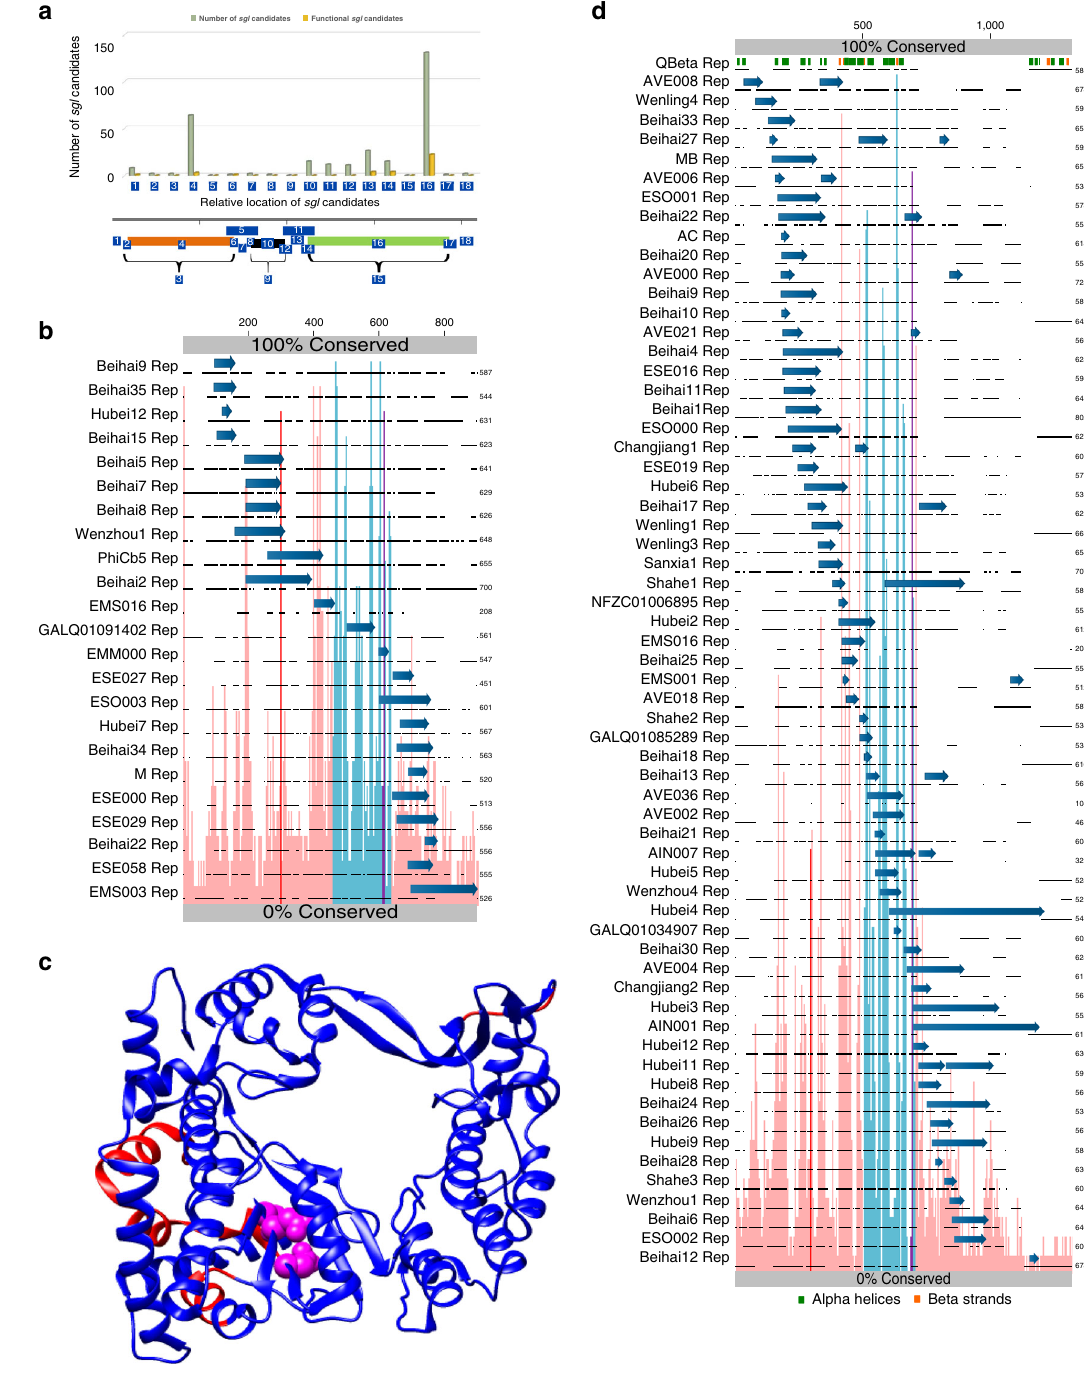
Fig. 2 Genomic hot spots for sgl evolution. a Relative location of sgl -candidates within a canonical ssRNA phage genome architecture. Numbers 1 through 18 refer to the sub-locations within the genome where sgl -candidates could potentially be found. The bars in the graph show the total number of sgl - candidates (light green) and functional sgl s (orange) per sub-location. b An alignment of Rep sequences from phage genomes that have rep -embedded functional sgl s. The regions of sequence similarity are shown as lines and the gaps are shown as breaks in the lines. The location of the sgl in the context of replicase primary structure is shown as a blue arrow above the line. Sequence conservation among the Rep sequences is shown as pink bars (0% at the bottom gray bar, 100% conservation top gray bar). The bars corresponding to conserved motifs are colored as follows GPGA = red; motifs A – E = light blue; FRESCG = purple. c The relative location of functional sgl s mapped on to the crystal structure of Q β RNA-Dependent RNA polymerase (RdRp) beta subunit (PDB:4R71). The structural elements that have tolerated evolution of embedded sgl s are highlighted in blue. The catalytically important residues are shown as magenta spheres and the regions without any functional sgl s are highlighted red. d An alignment of Rep sequences from phage genomes that have rep -embedded non-functional sgl candidates with Q β Rep as a reference at the top. Annotations are the same as in b , except the secondary structure elements (alpha helices = green rectangles; beta strands = orange rectangles) are annotated above the Q β